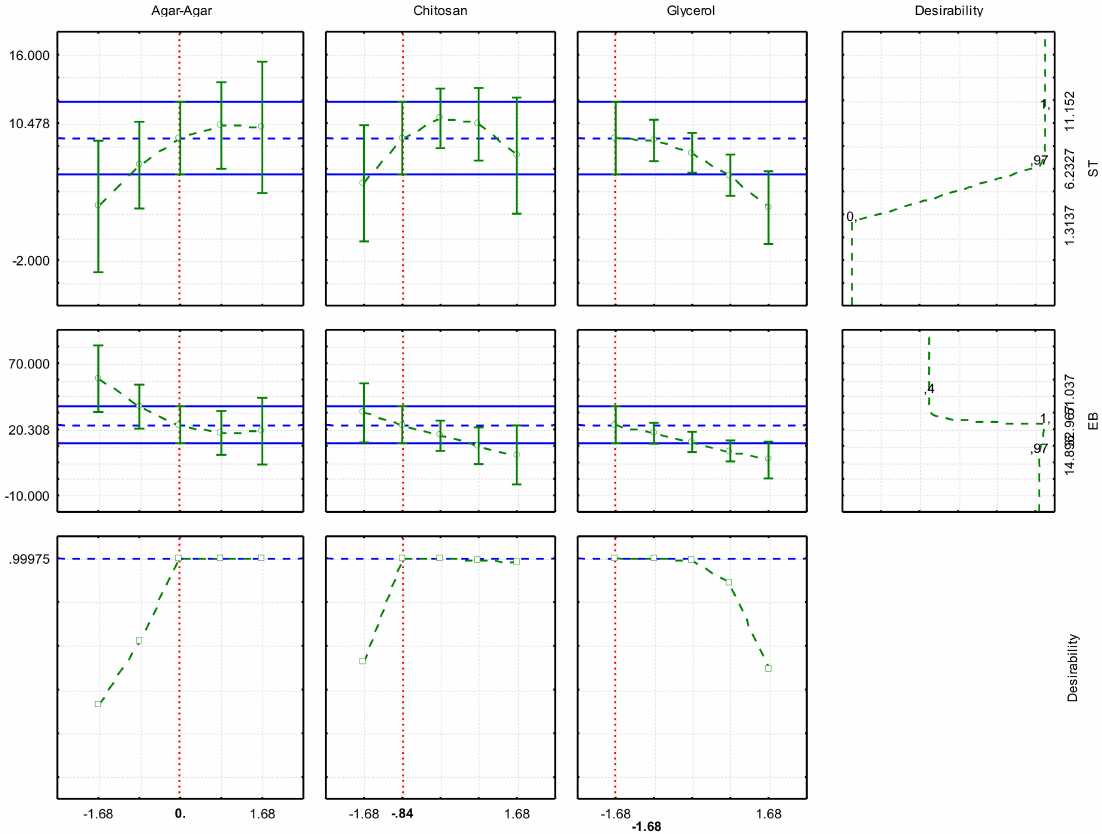
Figure 2. Desirability function (TS and EB